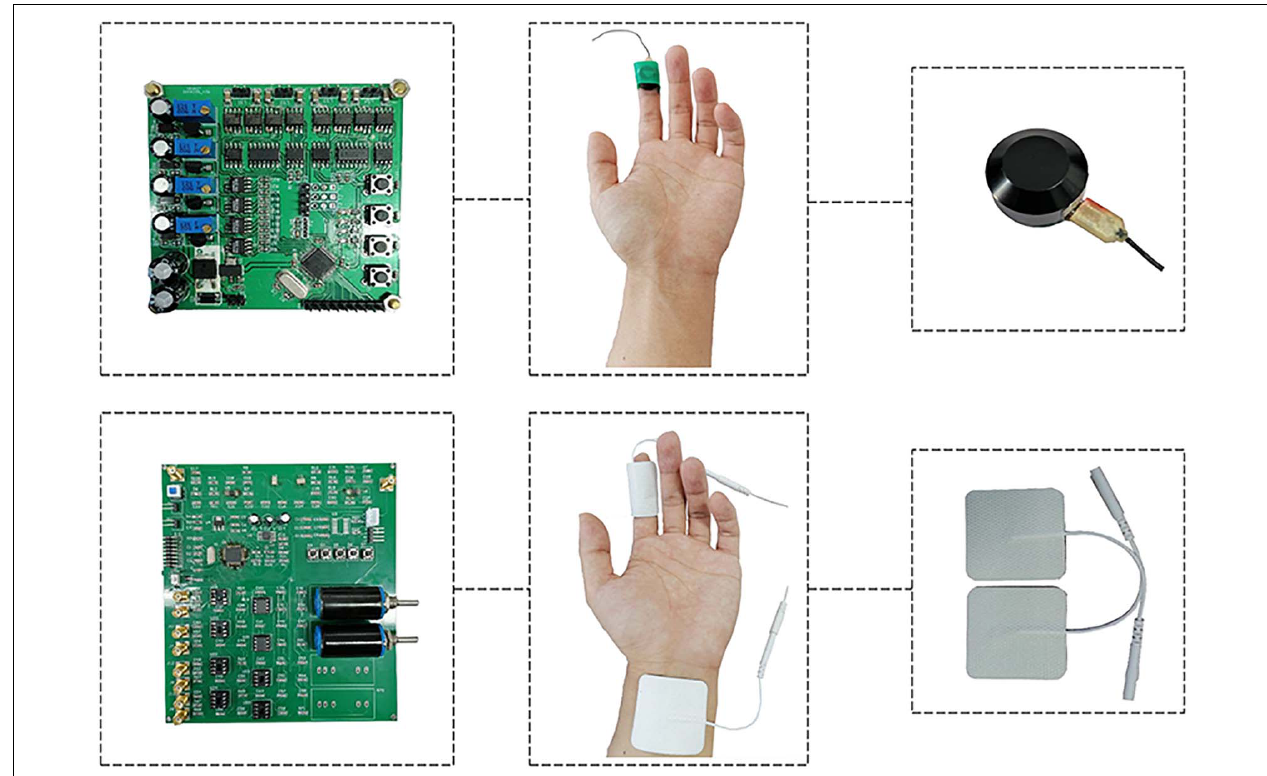
FIGURE 1 | Devices for generating electrical and vibration stimuli: (1) Vibration stimulus trigger device on the top row: Four-channel DC motor drive (module STM32F103) with a rated power of 2 W. The driving voltage was adjustable from 0 to 5 V, and the vibration frequency was able to be changed from 0 to 300 Hz. (2) Electrical stimulus trigger device on the bottom row: Dual-channel STM32F103 arbitrary waveform generation module with a 12 V DC power supply. The output voltage could be adjusted from 2 to 12 V, and the output frequency was within the range of 0–1,000